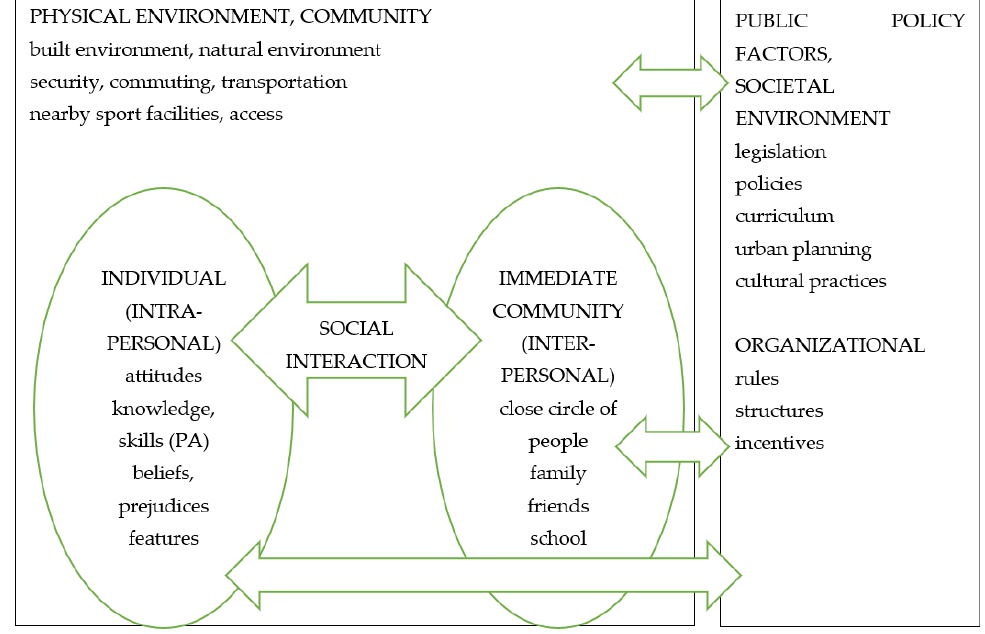
Figure 1. Interaction between the different levels of the socio-ecological model, framework modified according to Bronfenbrenner [48,49] and Elder et al. [12].